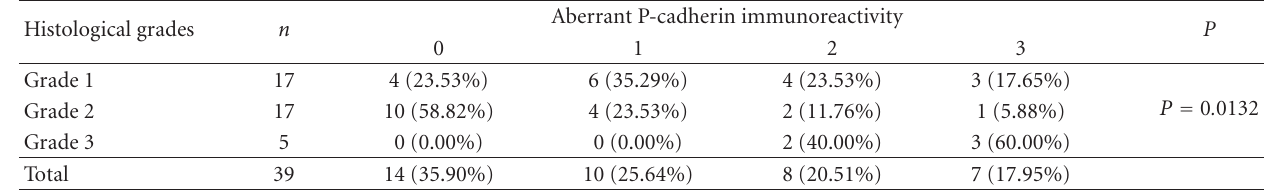
Table 5: Relationship between aberrant P-cadherin immunoexpression and histological grade of malignant tumours. Histological